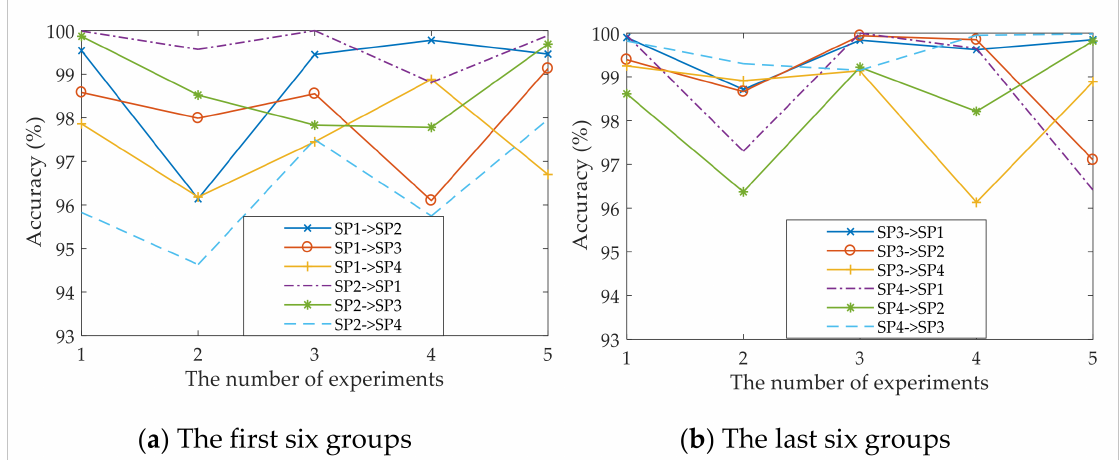
Figure 5. The five consecutive test results of the DAN-DAM model in diverse transfers for open